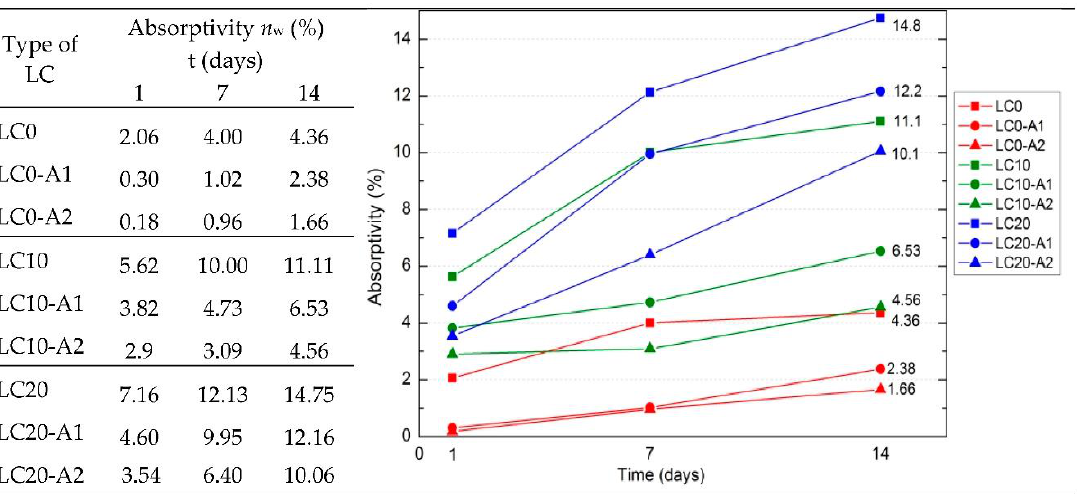
Figure 2. Water absorptivity n w by weight of LC in time (%).